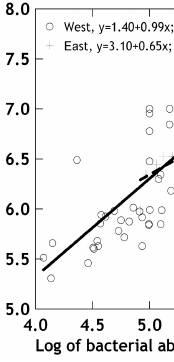
Fig. 13. Relationship between bacterial and viral abundance (log transformed), taken at depths between 5 and 200m, for WMS and EMS waters.